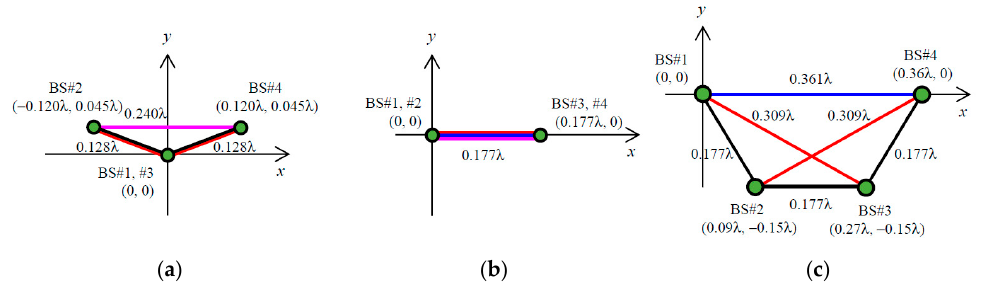
Figure 12. Arrangement of virtual point sources: ( a ) φ = 45° in a circular array; ( b ) φ = 0° in a circular array; ( c ) φ = 0° in a linear array.